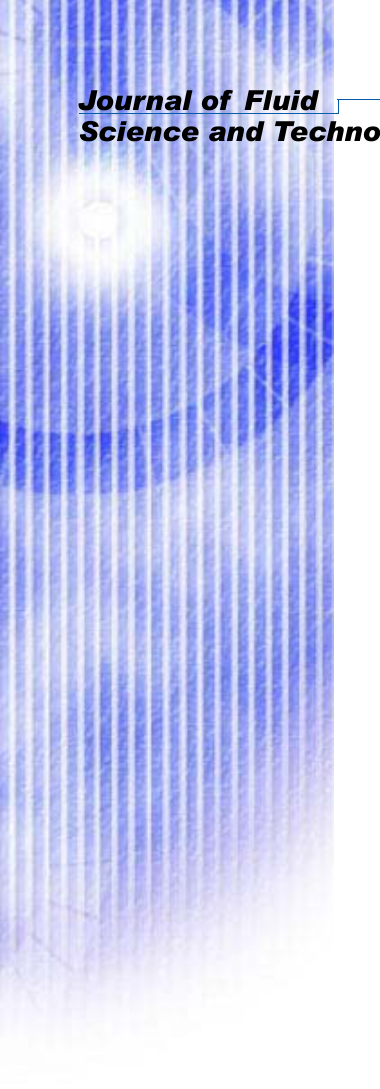
. Thin solid lines in Fig. 7 represent this